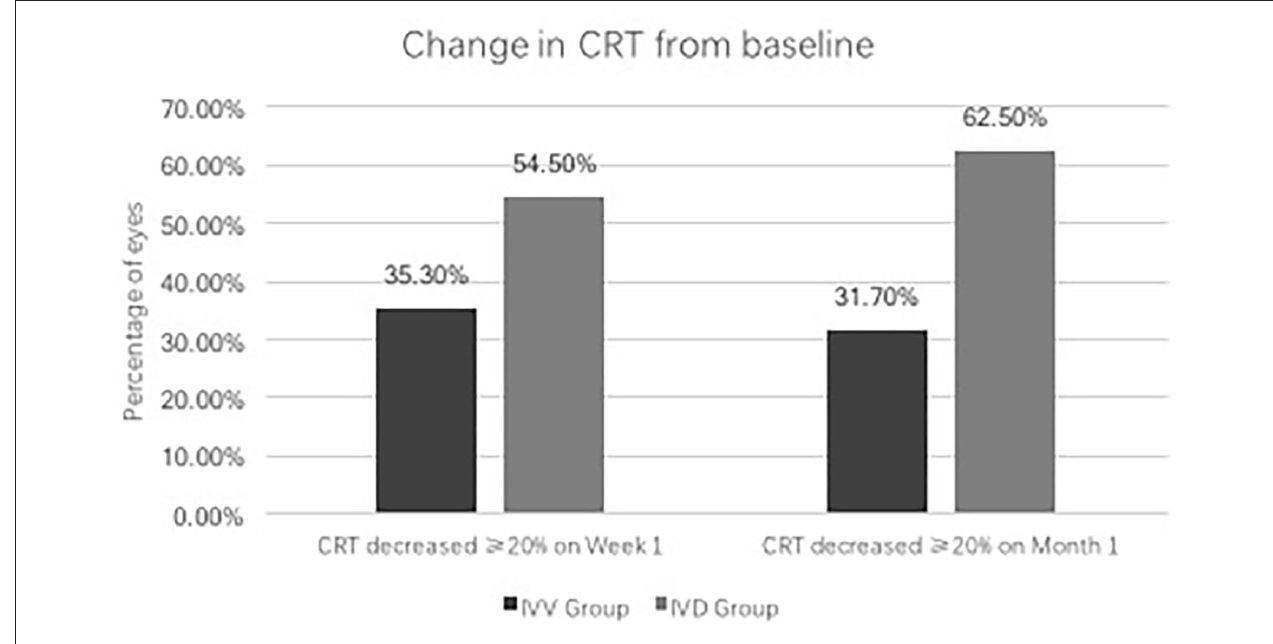
FIGURE 3 | Change in CRT from baseline.